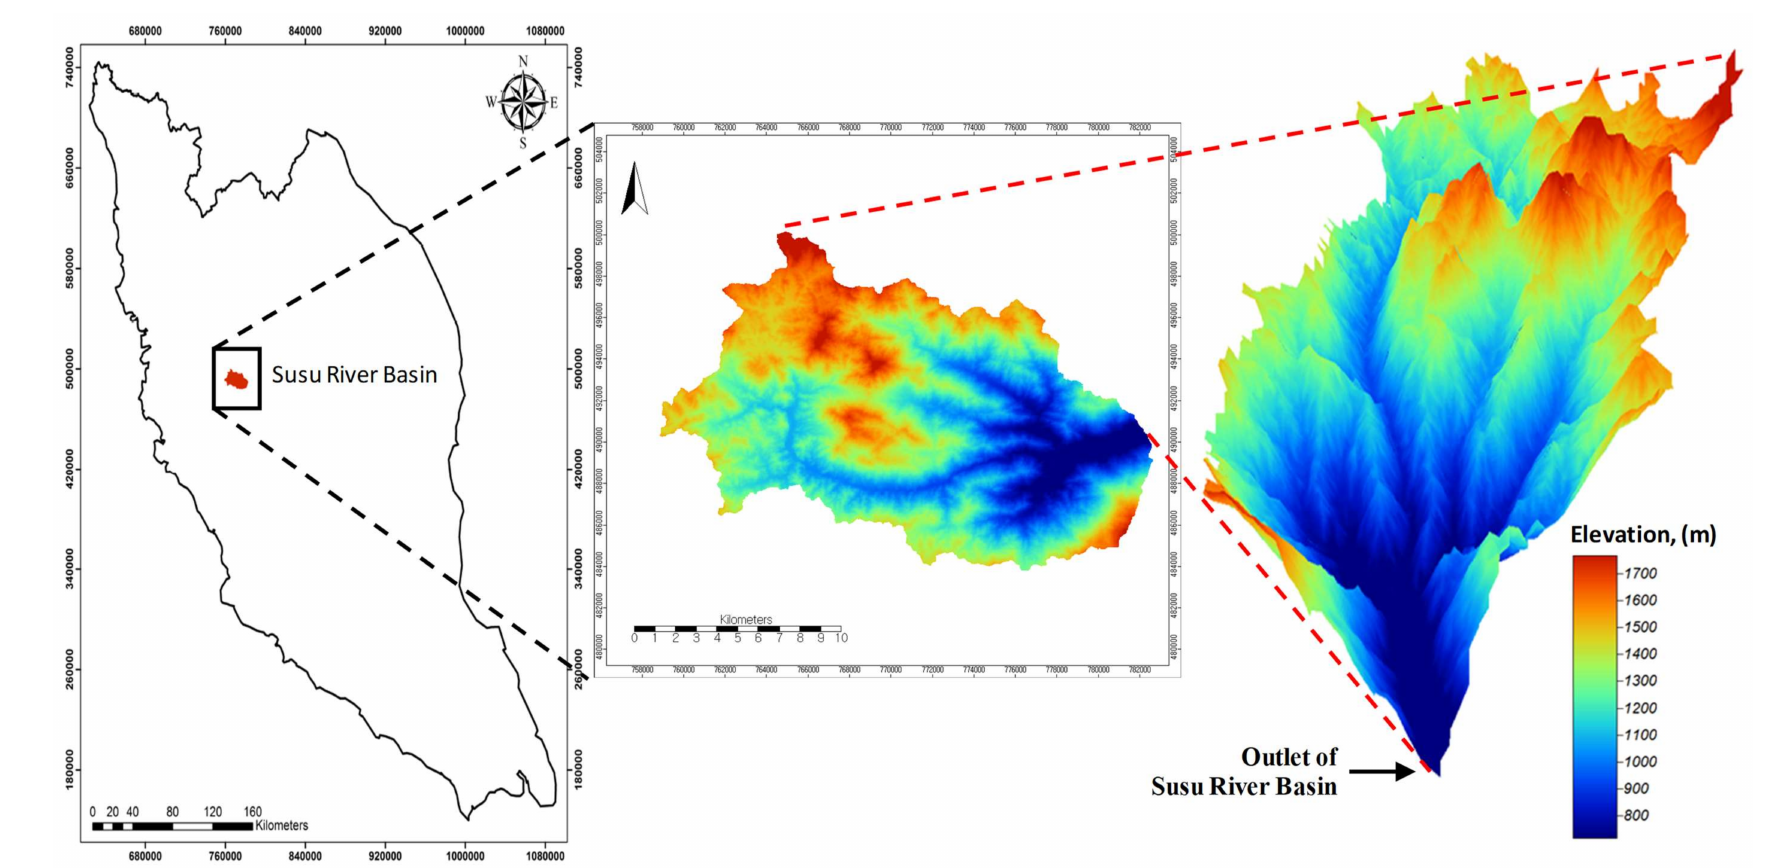
Figure 1. Geographical location, elevation map, and three-dimensional plot of the Susu River